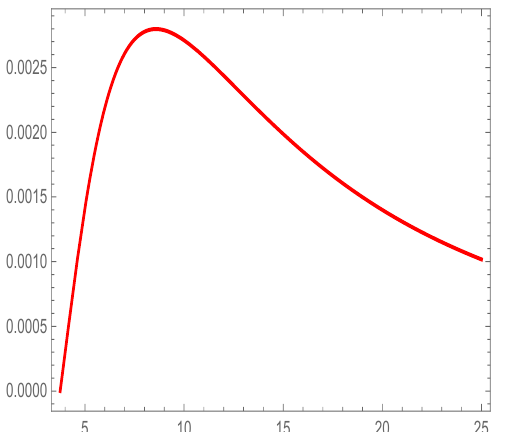
Figure 3. Variation of the effective potential with r for β = 2.9 for M = 1, L = 1 and ξ =